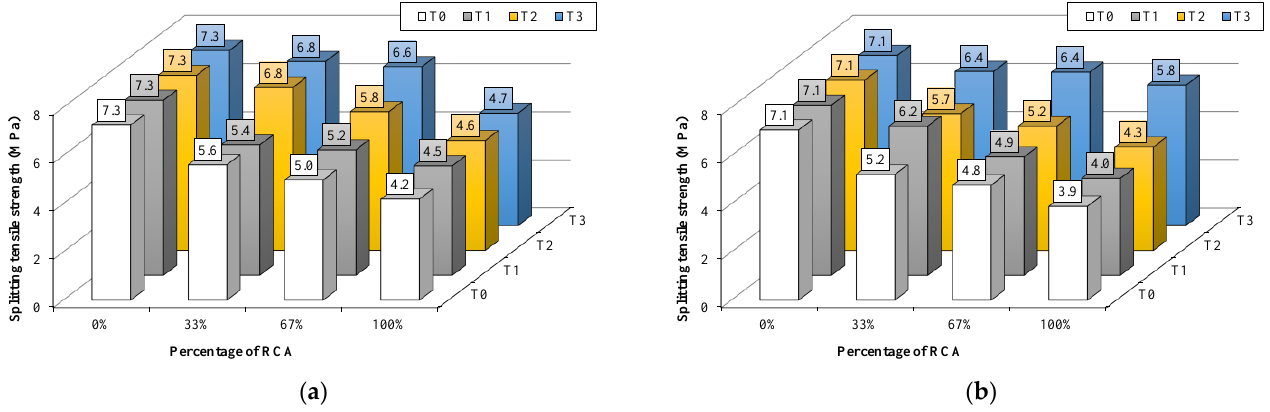
Figure 12. Splitting tensile strength results of untreated and treated RCA for: ( a ) 10-mm aggregate; and ( b ) 20-mm aggregate.